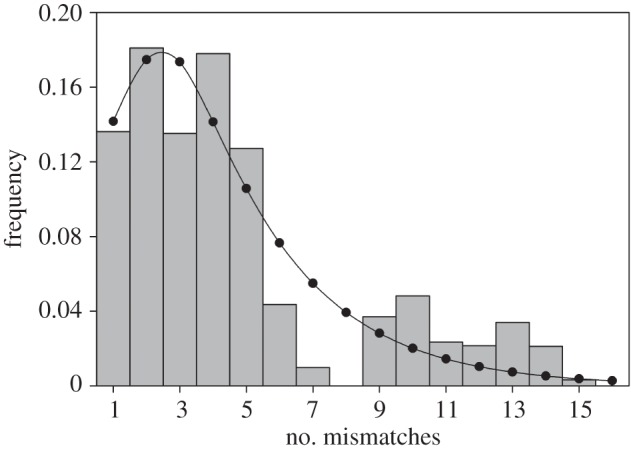
Histogram showing the observed distribution of pairwise differences among mitochondrial haplotypes obtained from the Falkland Islands. For comparison, the line with black points represents the expected distribution under a model of sudden population expansion.